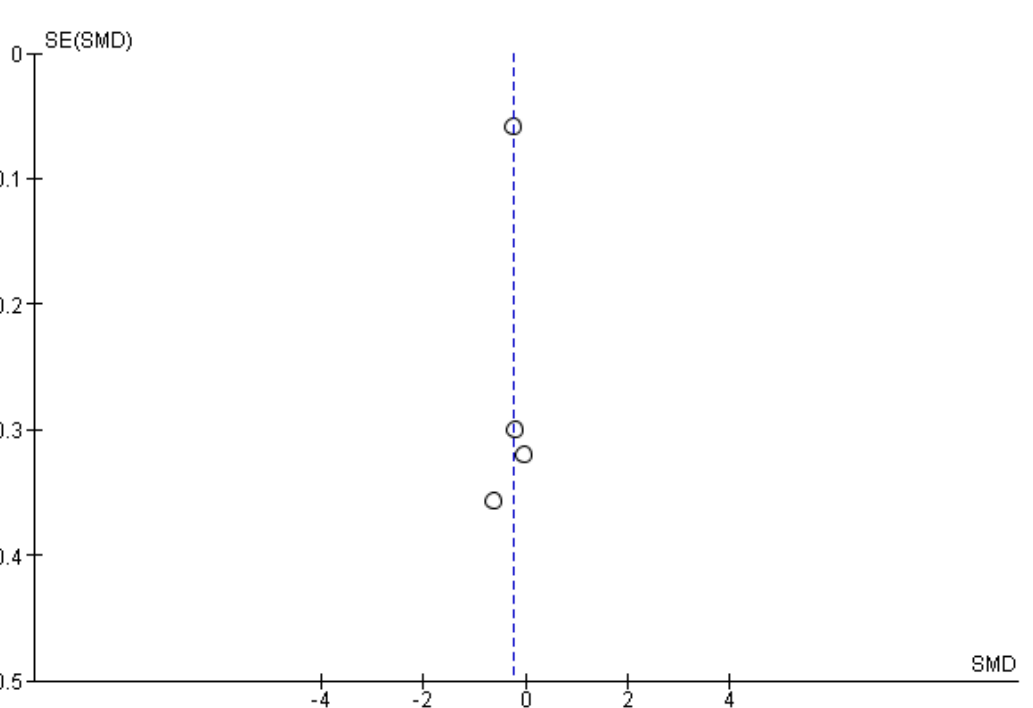
Figure 7. Anxiety post- vs. pre-nature walk funnel plot.